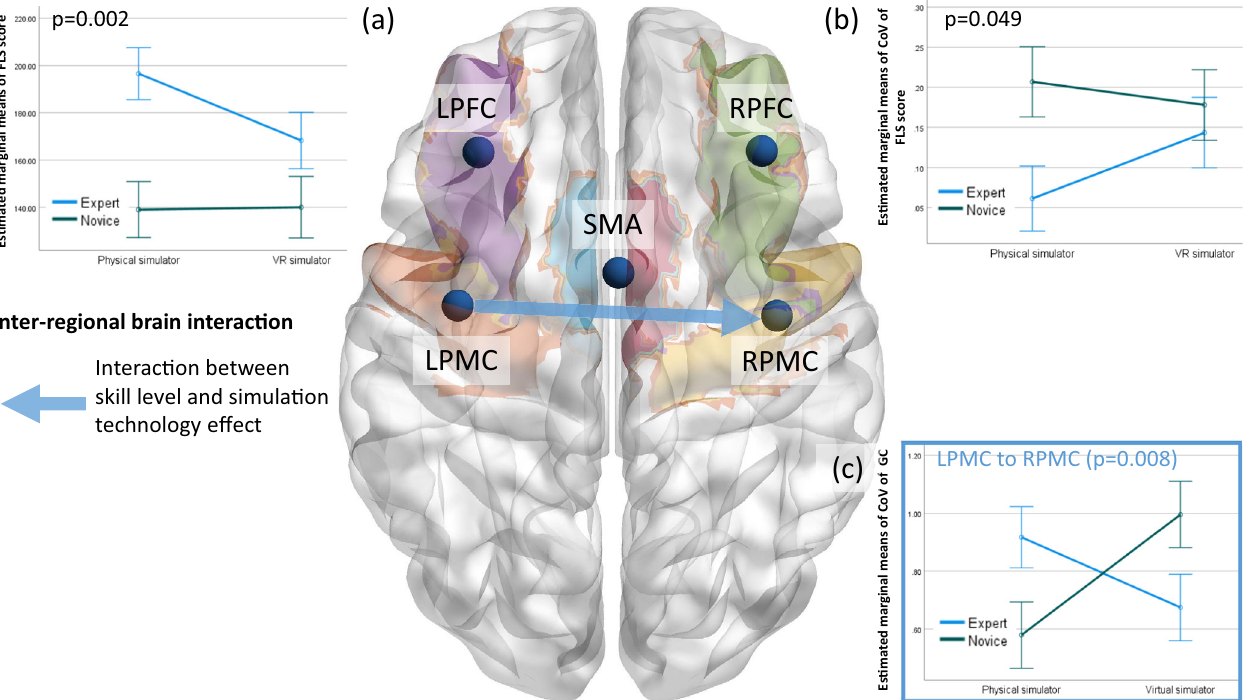
Fig. 3 Brain-behavior analysis based on the coef fi cient of variation. Estimated marginal means of a signi fi cant ( p = 0.002) effects of skill level on the FLS performance score and b signi fi cant ( p = 0.049) effects of skill level on the coef fi cient of variation (CoV) of the FLS performance score. c Signi fi cant ( p = 0.008) effect of the interaction between skill level and the simulator technology on the coef fi cient of variation (CoV) of LPMC- to RPMC-directed functional connectivity. Error bars show the standard error. Signi fi cant (after controlling for a false discovery rate of 0.05 with Benjamini – Hochberg adjustment) interregional directed functional brain connectivity is shown with a blue arrow for the interaction between skill level and the simulator technology on the